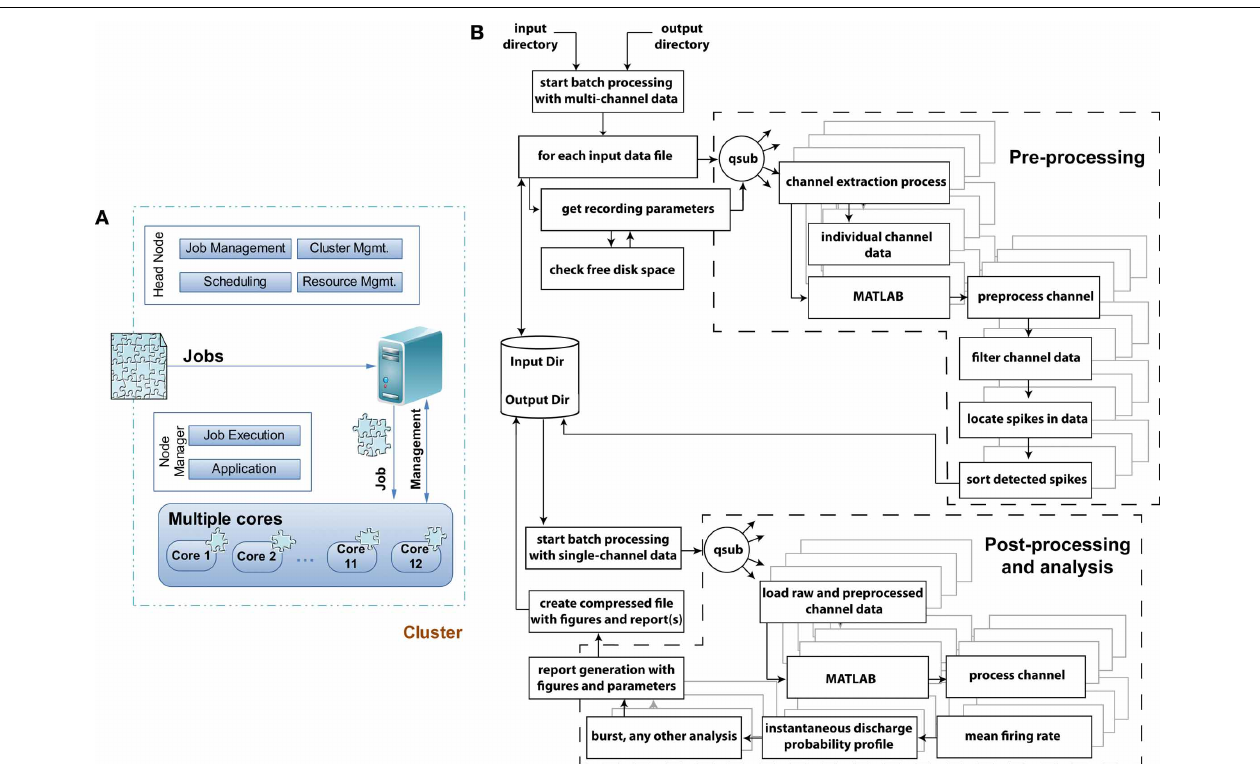
FIGURE 3 | Grid computing architecture and flowchart of the data pre-, post-processing, and analysis module. (A) When jobs arrive at a grid computing environment, the jobs are decomposed into individual jobs and allocated to each processor core or cluster for completion. In a multicomputer cluster system the head node of the cluster is responsible for job-, cluster-, resource-management and scheduling leaving the application and job execution on the individual nodes of the cluster system. In QSpike Tools the benefit of a multicore single computer cluster has been exploited where the responsibilities of the